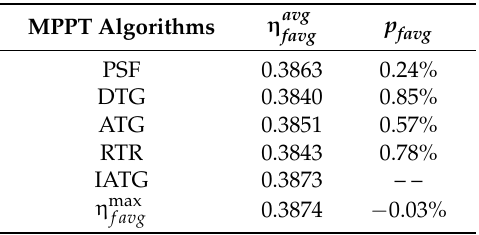
Table 6. Improvements of IATG control over conventional control